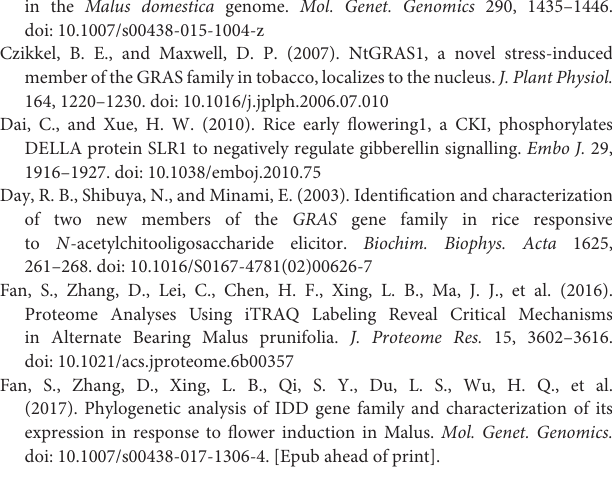
Table S4 | Investigation of flowering rate in